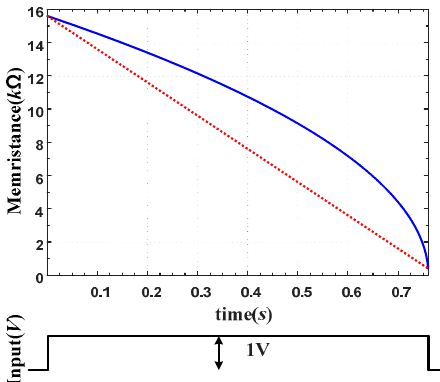
Figure 9. Nonlinear variation of the memristance about time of TiO 2 memristor model when a constant voltage (rectangular pulse) is applied.